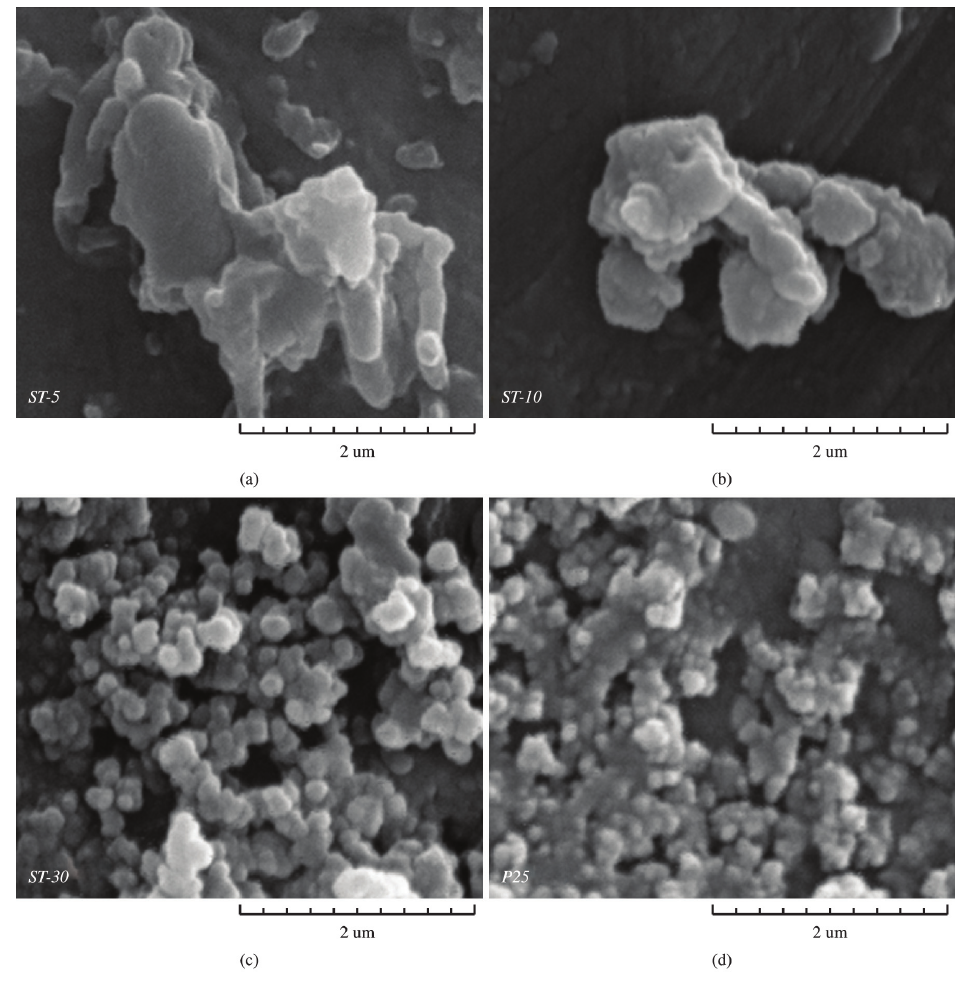
Figure 2. SEM images of the TiO2 samples: (a) ST-5, (b) ST-10, (c) ST-30 and (d) P25.